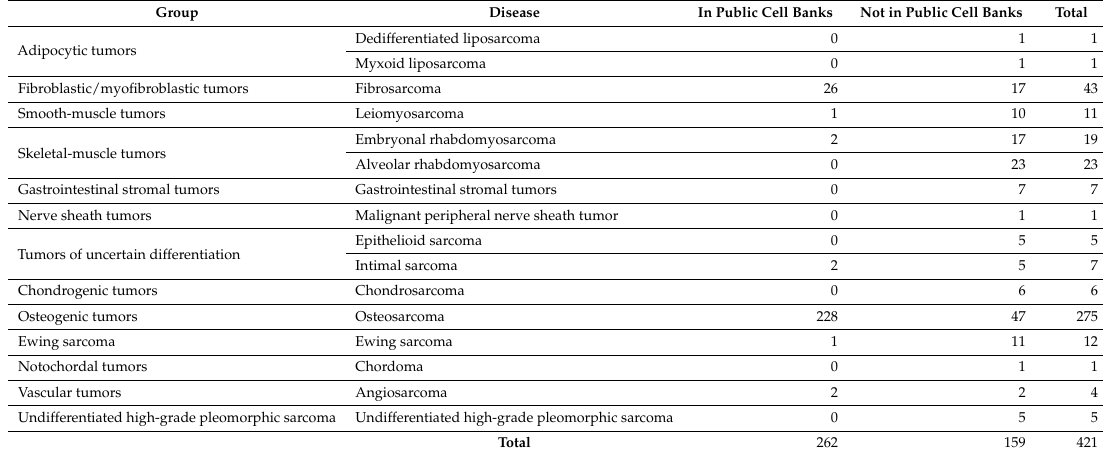
Table 2. Availability of WHO classified and modified cell lines.